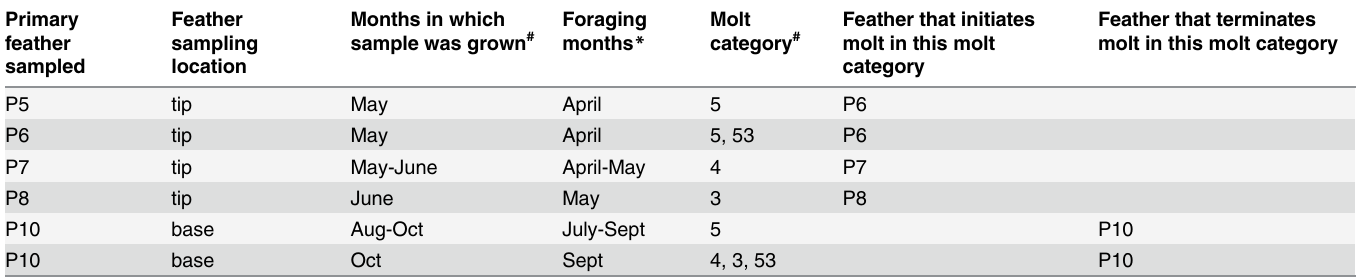
Table 1. Feathers sampled and sampling location (within the feather), estimated months in which the sample was grown, estimated months of for- aging represented by the sample, associated molt category (that determines feather to be sampled) and initiation and termination feather for each molt